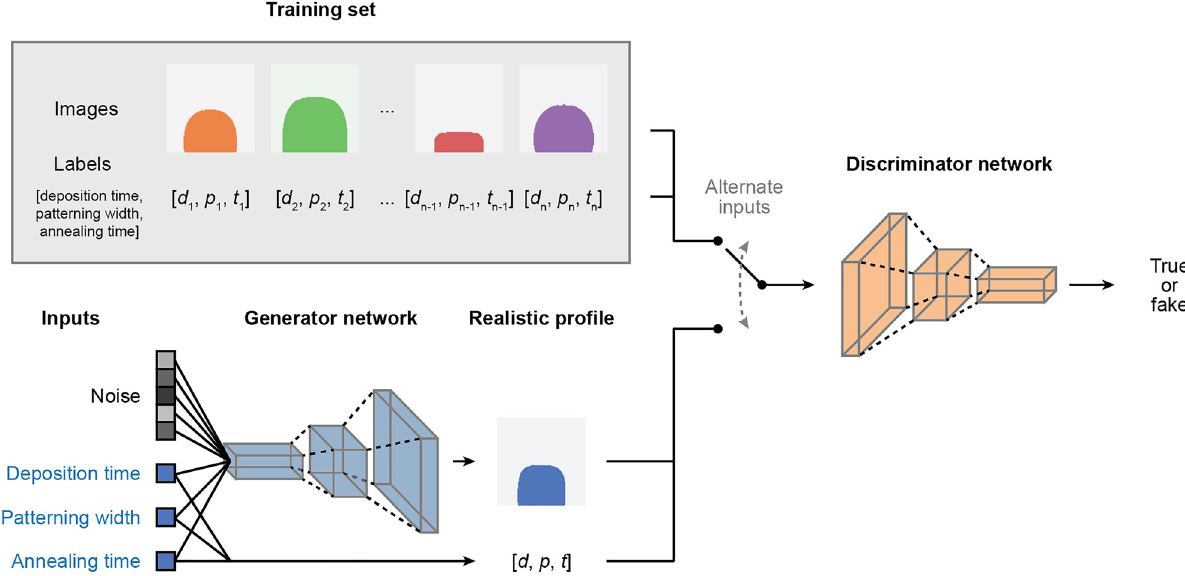
Figure 2: Training process.The training set is composedof both the images andtheir labels. The generatortakes random noiseand labels as its inputs and outputs a grating profile. The discriminator network alternates between receiving images and labels from the training set and generator network, and tries to determine if its input is real (from the training set) or fake (created by the generator